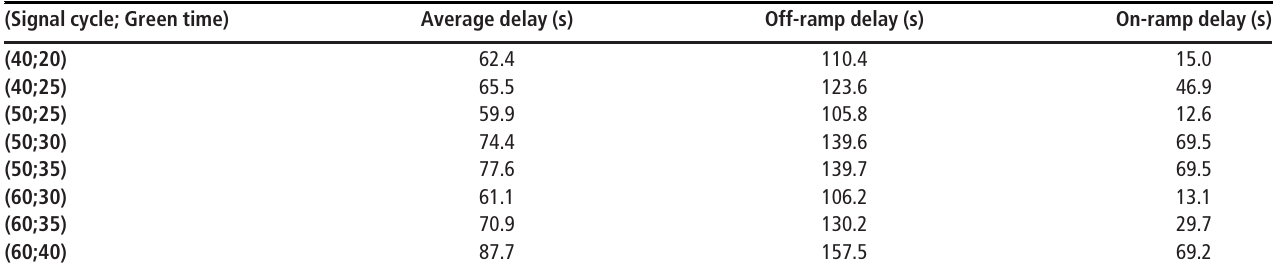
Table 3 Summary of different signal cycle delays of Scenario V (Signal cycle; Green time)